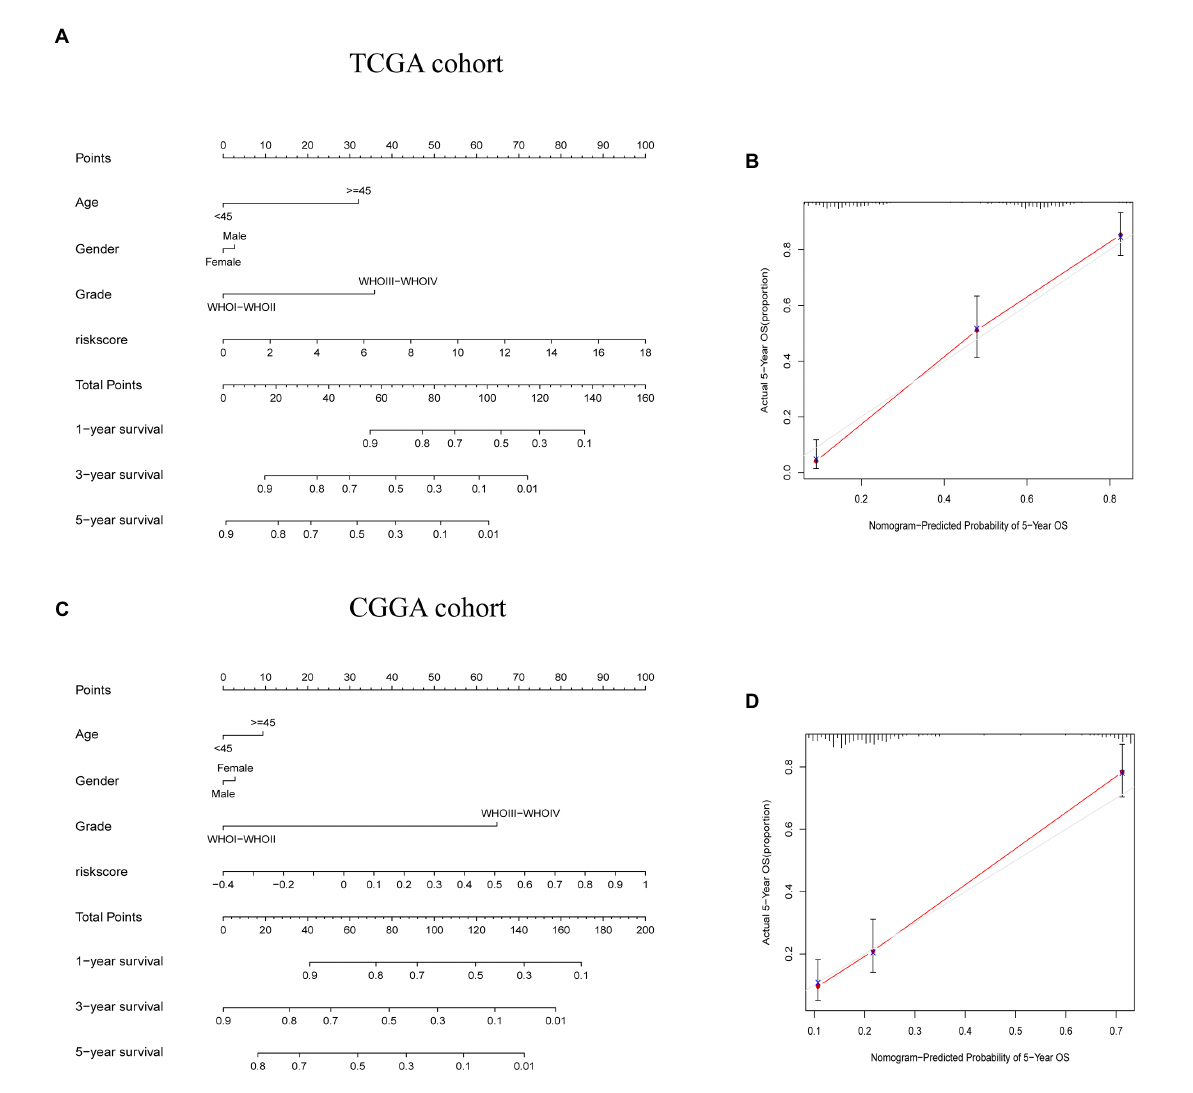
FIGURE 9 Construction and validation of a nomogram to predict overall survival (OS). (A,C) Nomogram for predicting 1, 3, and 5-year OS for people with glioma in the TCGA and CGGA cohorts. (B,D) Calibration curves for the nomogram to predict 5-year OS in TCGA and CGGA